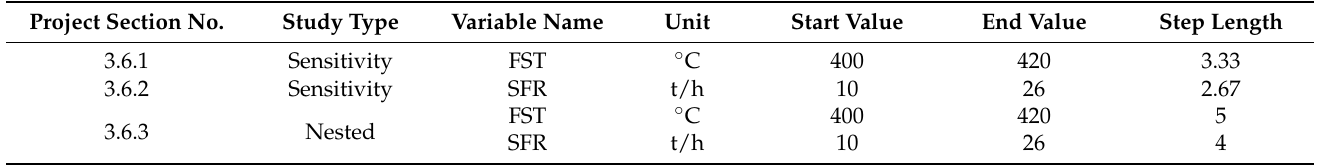
Table 5. Parameter setting of independent variables in case